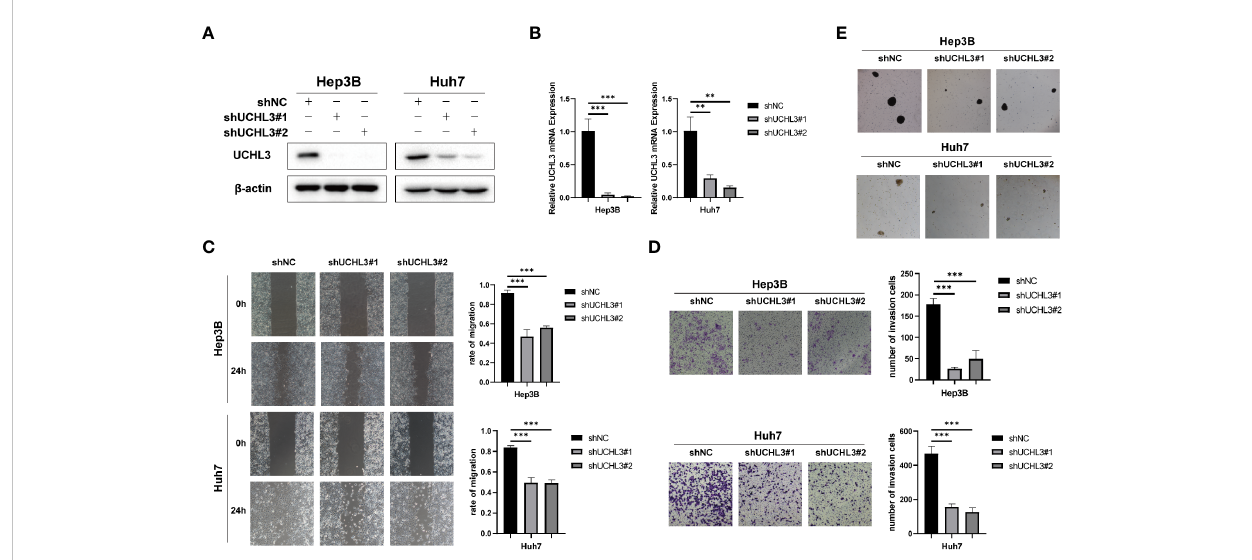
FIGURE 3 UCHL3 knockdown inhibited migration and stem-like properties of HCC cells. (A) Knockdown of UCHL3 in Hep3B and Huh7 cells was con fi rmed by Western blotting. (B) RT-qPCR showed reduced expression of UCHL3 mRNA in Hep3B and Huh7 cells. (C) UCHL3 knockdown suppressed Hep3B and Huh7 cell migration during wound healing assays. (D) UCHL3 knockdown suppressed Hep3B and Huh7 cell migration during Transwell assays. (E) UCHL3 knockdown inhibited spheroid formation in Hep3B and Huh7 cells. **p < 0.01, ***p < 0.001.